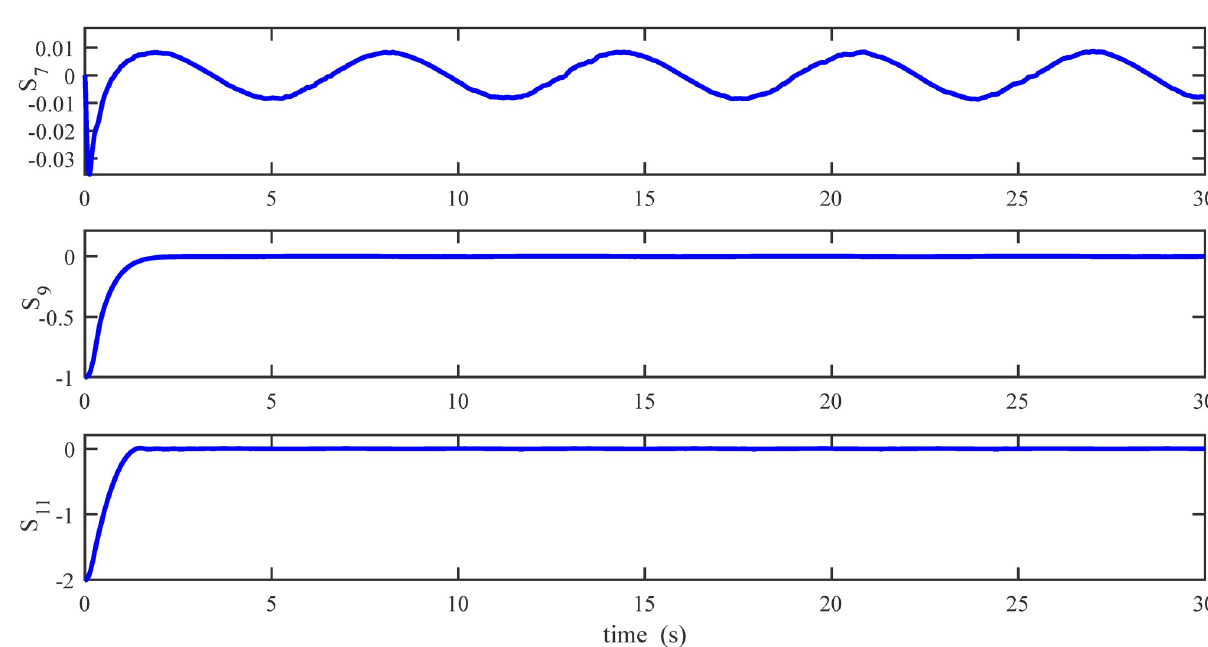
Fig 16. Results of the position sliding variables under the proposed controller.